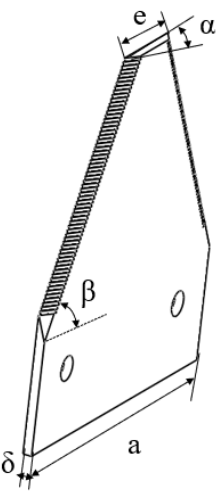
Figure 3. Schematic diagram of the moving blade. Table 1. Parameters of the moving blade.